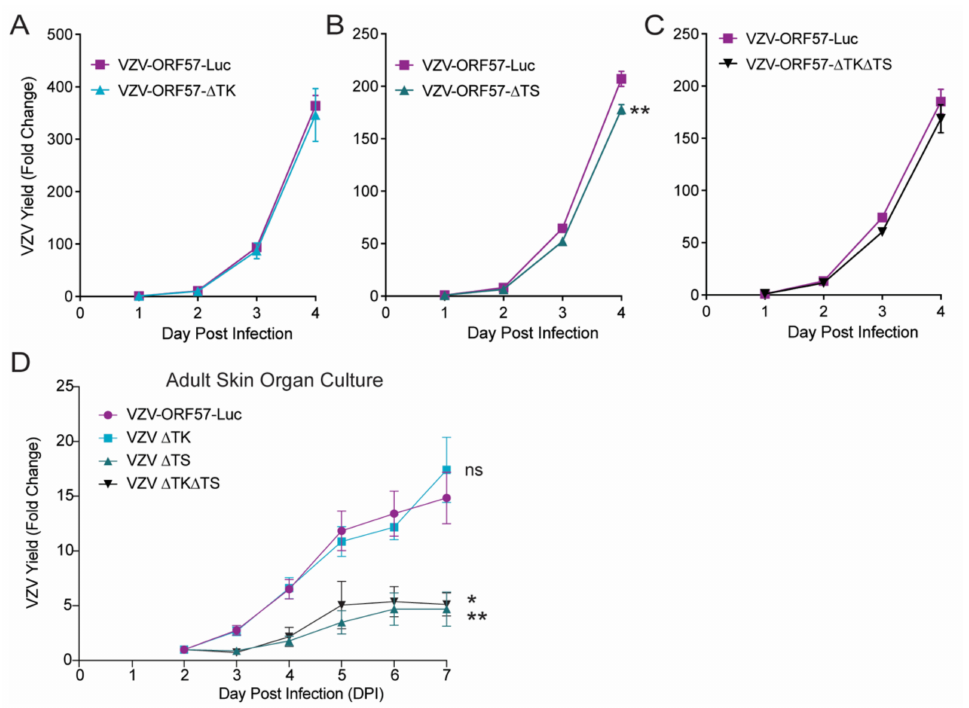
Figure 4. VZV TK is dispensable while VZV TS is required for optimal growth in cells and is critical for human skin organ culture. Cell-free VZV was added to ARPE-19 monolayers at 37 ◦ C ( A – C ; 1:50 ratio) or introduced to adult human skin ( D ; 1 × 10 4 –10 5 pfu/mL; 30 µ L inoculum) by scarification, placed on NetWells, and incubated at 35 ◦ C. Virus spread was monitored daily by bioluminescence imaging. Cell cultures were infected with up to 500 pfu/well. Skin was infected with 300–3000 pfu/piece of skin, depending on the viral titer that could be attained in ARPE-19 cells. VZV-ORF57-Luc was grown independently in ARPE-19 for each assay in ( A – C ), and directly compared to ( A ) VZV-ORF57- ∆ TK, ( B ) VZV-ORF57- ∆ TS, or ( C ) VZV-ORF57- ∆ TK ∆ TS under the same conditions. ( D ) Growth kinetics of ∆ TK, ∆ TS, and ∆ TK ∆ TS in adult human skin explants were evaluated for significance compared to parental VZV-ORF57-Luc on DPI 7. VZV yield was calculated as the average Total Flux each day divided by the Total Flux on ( A – C ) DPI 1 or ( D ) DPI 2. Each point and line represent the mean ± SEM. ( A – C ) Student’s t -test or ( D ) one-way ANOVA with Dunnett’s post hoc test; * p < 0.05; ** p < 0.01, ns = not significant. n = 6 biological